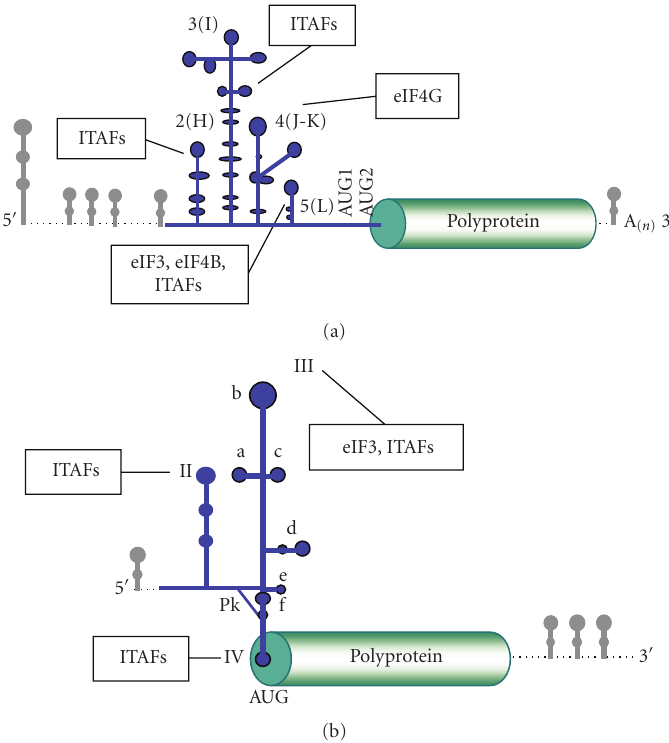
Figure 1: (a) Schematic representation of the picornavirus genome, using as example the foot-and-mouth disease viral RNA. (b) Schematic representation of the hepatitis C virus genome. The IRESs are depicted in blue, with indication of the domains referred to in the text. The position of the functional initiator AUGs, as well as the preferential binding sites of eIFs and ITAFs are indicated. Stable stem-loops located at the 5 (cid:2) and 3 (cid:2) end of the viral RNA are depicted in